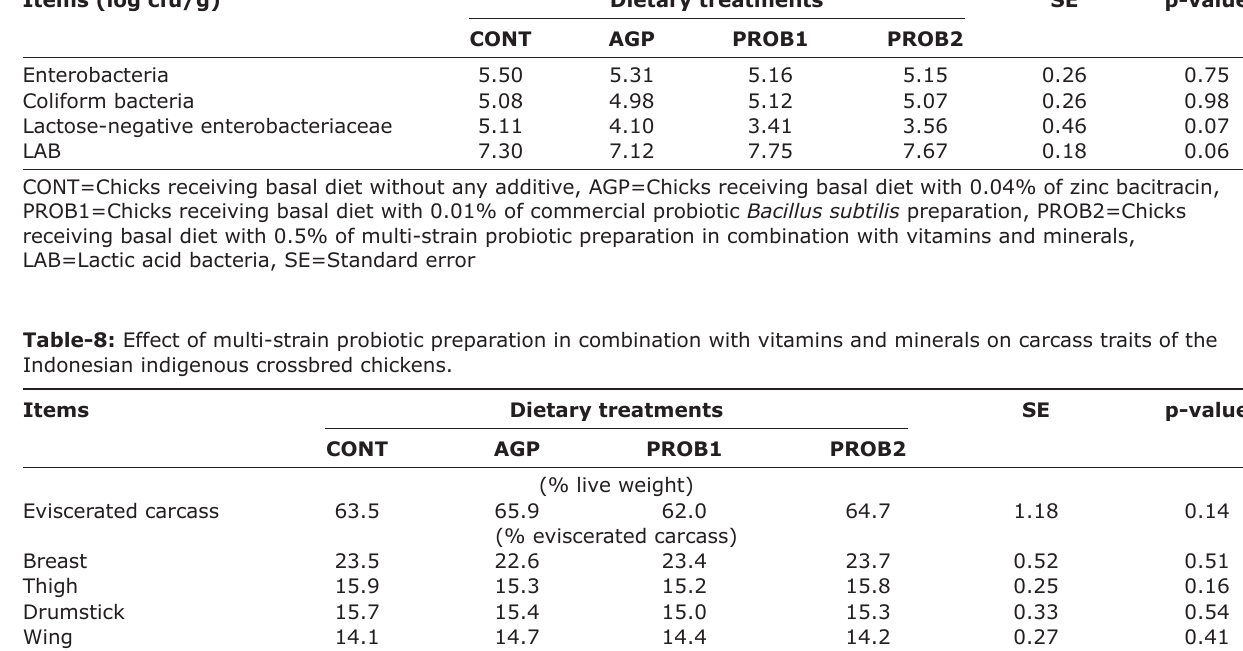
Table-7: Effect of multi-strain probiotic preparation in combination with vitamins and minerals on selected bacterial populations in the ileum of the Indonesian indigenous crossbred chickens. Items (log cfu/g) Dietary treatments